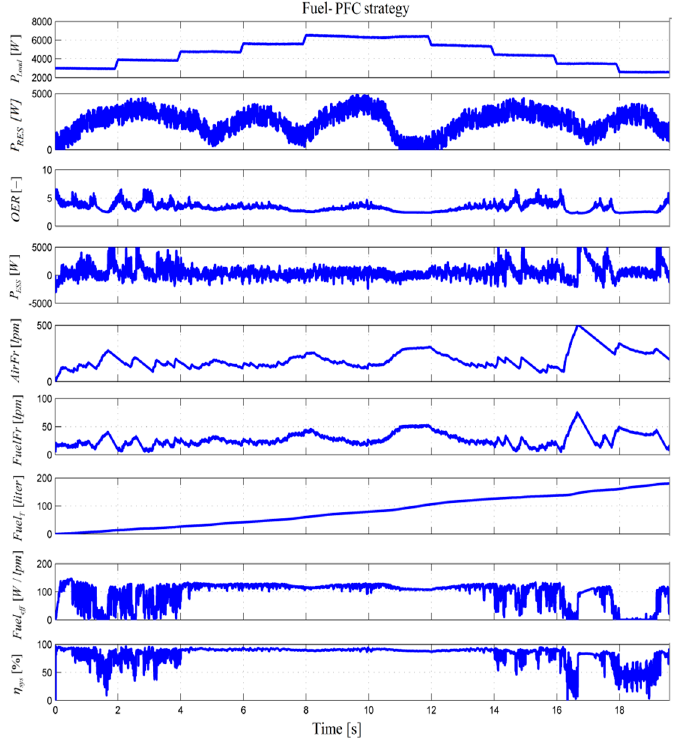
Figure 12. FC / renewable HPS behavior using the fuel-PFC Figure 12. FC/renewable HPS behavior using the fuel-PFC strategy.